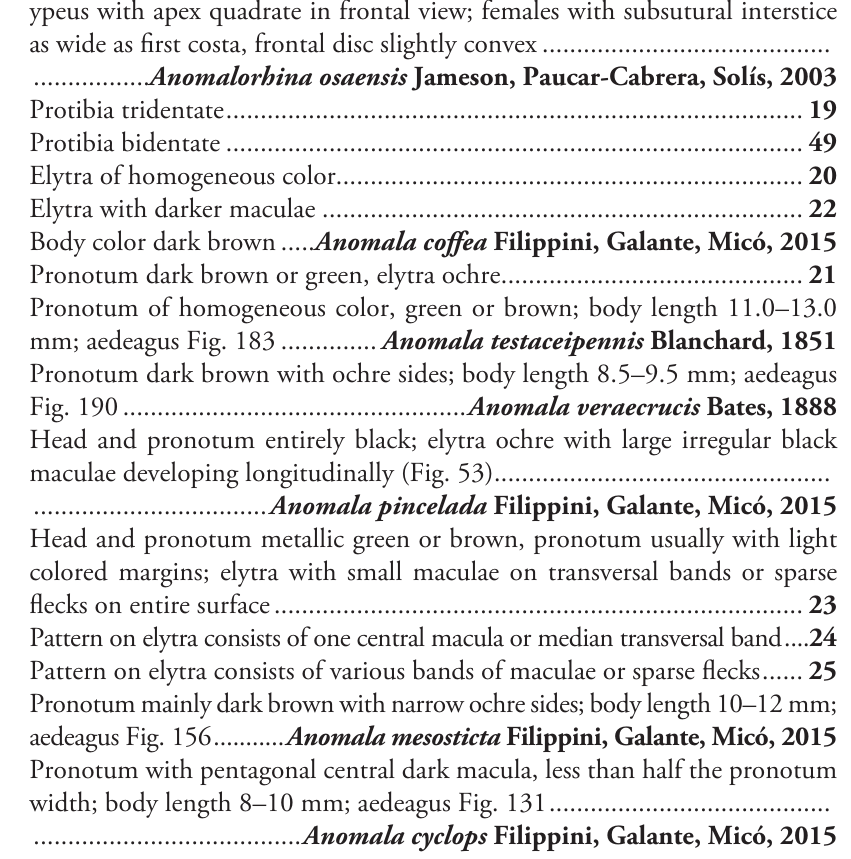
– 16 Rounded shape; pronotum strongly convex, as wide as base of elytra; body – Elongated shape; pronotum slightly convex, narrower than base of elytra; 17 Head and pronotum rufous, elytra black or reddish brown; male with two tu- bercles on base of frons; clypeus with apex acute in frontal view; females with subsutural interstice twice as wide as first costa, frontal disc slightly concave – Head, pronotum and elytra castaneous; male without tubercles on frons; cl- ypeus with apex quadrate in frontal view; females with subsutural interstice